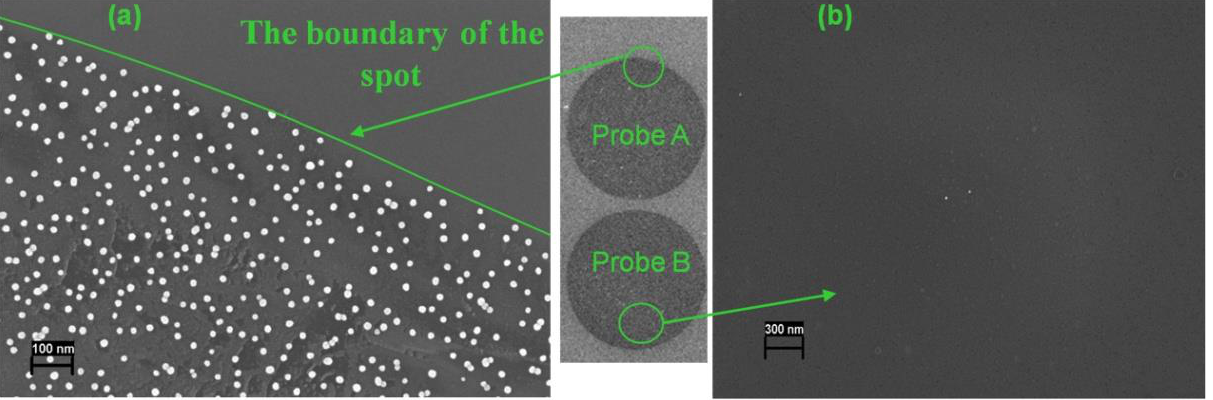
Figure 3. SEM images of the specific microchip spots after hybridization of 300 pM target Probe C with complementary Probe A ( a ) and non-complementary Probe B ( b ). Biotin in DNA duplexes was developed with a streptavidin – GNPs